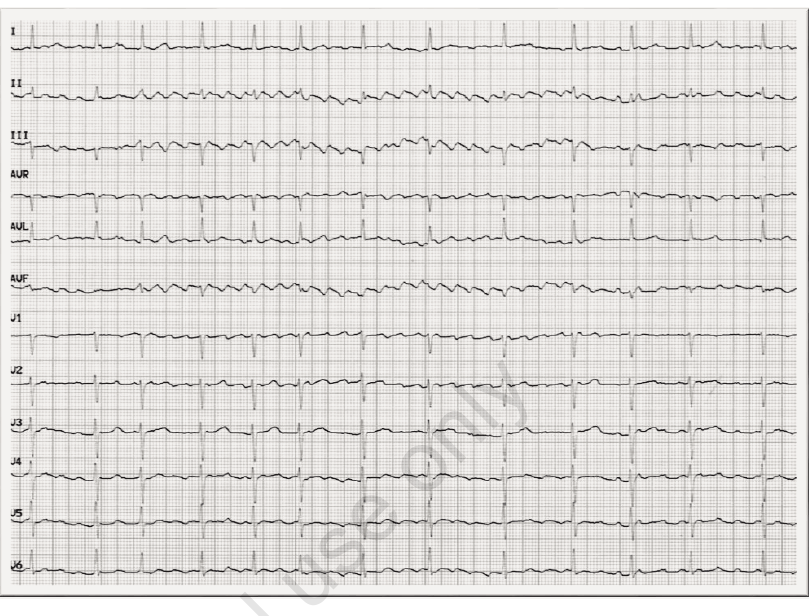
Figure 1. First ECG after resuscitation showing atrial fibrillation as the baseline rhythm.